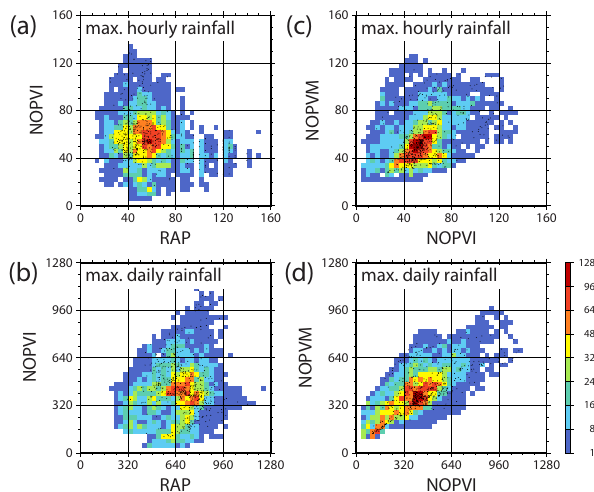
max. hourly rainfall